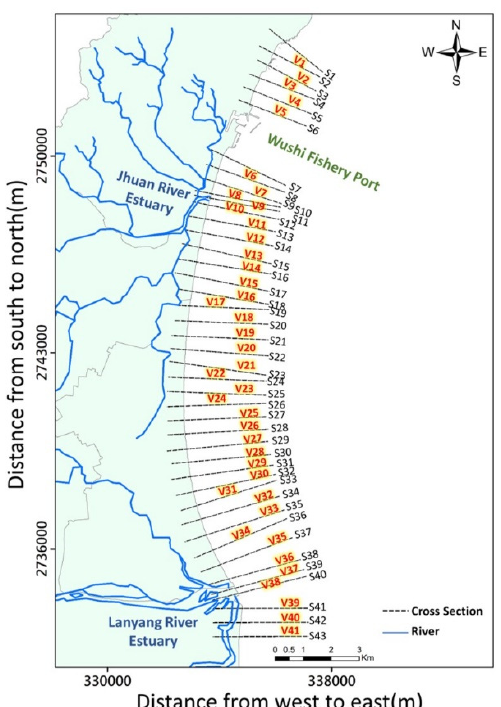
Figure 4. Spatial distribution of the cross sections for sampling bathymetry.